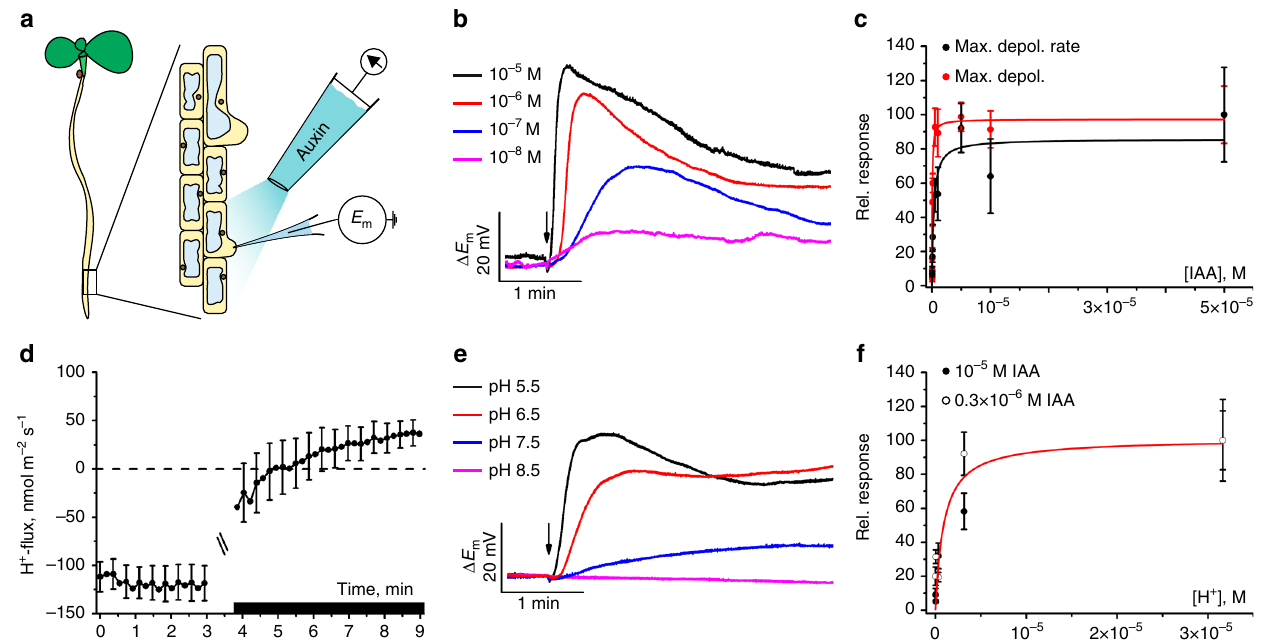
Fig. 1 Auxin-induced plasma membrane depolarization and associated H + - fl uxes in root-hair cells. a Experimental set-up: Intracellular microelectrodes measured the membrane potential of bulging root-hair cells and auxin was applied with an application pipette by back pressure. b Representative changes in membrane potential evoked by 1 s IAA pulses (10 − 8 to 10 – 5 M, arrow indicates time point of stimulation). c Dose – response curves of plasma membrane depolarization at a range of IAA concentrations, given as the percentage of the maximal depolarization (red symbols) and maximum rate of voltage change (black symbols). Apparent K m values according to Michaelis – Menten fi tting were 53 ± 6 nM (max depol) and 300 ± 133 nM (max velocity) IAA ( n = 6 ± s. e.m.). Note that K m values were calculated from undiluted auxin concentrations inside application pipettes. d H + - fl ux kinetics determined with ion-selective electrodes, scanning in close proximity of root-hair cells. After 3 min, IAA was applied to a fi nal concentration of 10 µ M (black bar, curves are interrupted at time point of IAA stimulation), n = 11 ± s.e.m. e Impact of extracellular pH on the IAA-induced depolarization (arrow, 1 s stimulation with 10 µ M IAA). f IAA-induced depolarization as a function of extracellular H + -concentration, given as percentage of the depolarization rate at pH 4.5. Similar values were obtained for an IAA conc. of 10 µ M (closed symbols) and 0.3 µ M (open symbols). Apparent K m value according to Michaelis – Menten fi tting was 910 ± 500 nM (i.e., pH 6.0; n = 6 for 10 µ M IAA and n = 10 for 0.3 µ M IAA). Error bars represent